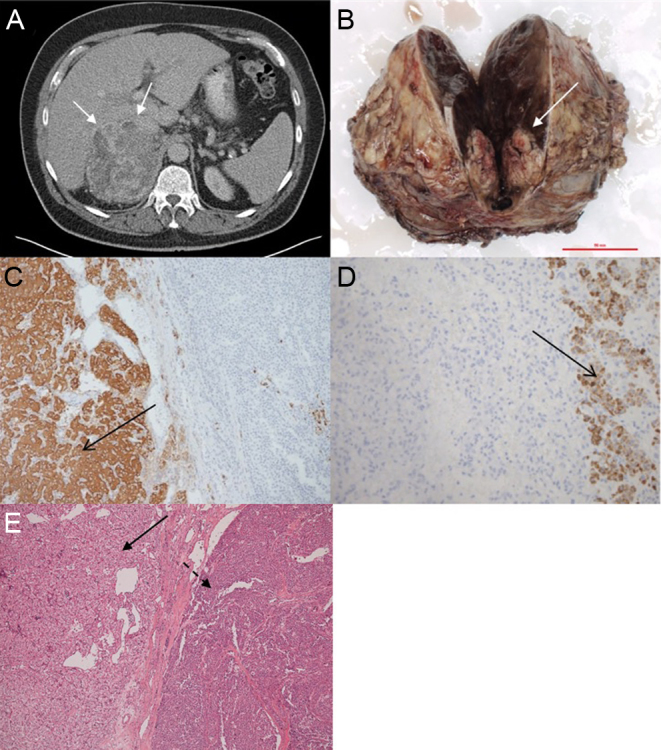
Imaging and immunohistochemistry characteristics of patient 1, a 65-year-old gentleman with an adrenal mass detected upon staging for a newly diagnosed melanoma. (Panel A) Abdominal CT revealing large, heterogeneous right adrenal mass (arrows). (Panel B) Adrenalectomy specimen with a melanoma metastasis (arrow) embedded in a sizeable phaeochromocytoma. (Panel C) Chromogranin staining showing positive phaeochromocytoma cells on the left (brown, arrow) and negative melanoma cells on the right. (Panel D) Melan A immunohistochemistry showing positive melanoma cells on the right (brown, arrow) and negative phaeochromocytoma cells on the left. (Panel E) H&E stain including the phaeochromocytoma on the left (arrow) and the melanoma metastasis on the right (dashed arrow).